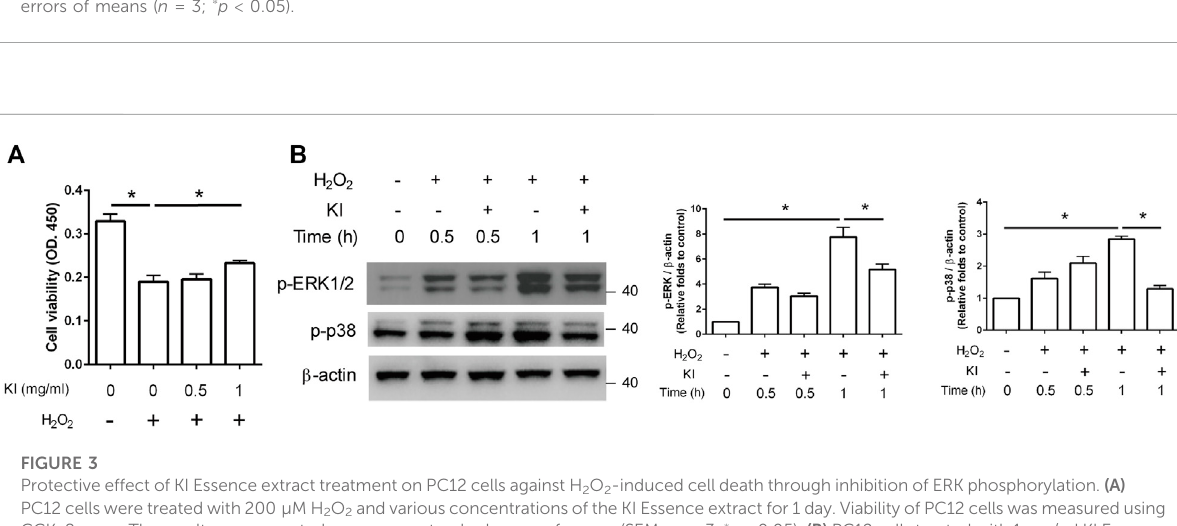
FIGURE 2 Characterization of KI Essence extract in radical scavenging and anti-lipid peroxidation properties. (A) 2,2 ′ -diphenyl-1-picrylhydrazyl (DPPH) scavenging property of the KI Essence extract and butylated hydroxytoluene. 500 µM DPPH were tested at various concentrations of the KI Essence extract and butylated hydroxytoluene. (B) Effects of the KI Essence extract on tert-butyl hydroperoxide (t-BHP)-induced lipid peroxidation in brain homogenates.BrainhomogenateswereincubatedwithvariousconcentrationsoftheKIEssenceextract(0,0.0625,and0.25 mg/ml)with(+)or without( − )t-BHPstimulationfor1 h.Malondialdehyde(MDA)contentsarepresentedinthebargraph.Theresultsarepresentedasmeans±standard errors of means ( n = 3; p p < 0.05).